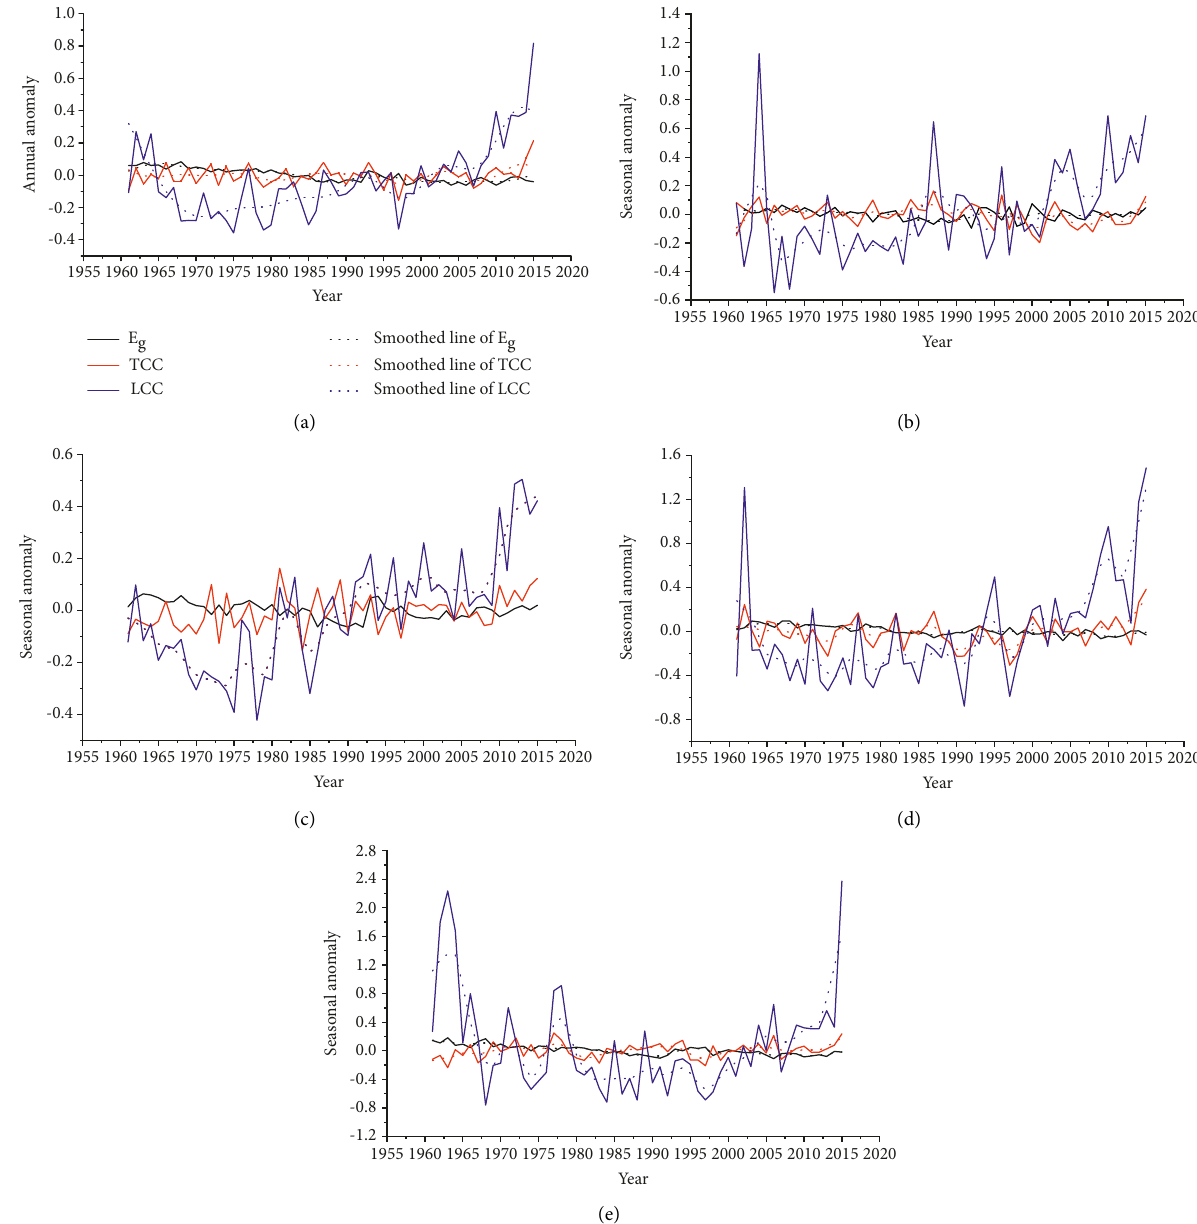
Figure 2: Interannual variations in the anomalies of E (dashed lines) by using the Lowess robust locally weighted regression algorithm. (a) Annual. (b) Spring. (c) Summer. (d) Autumn. (e)